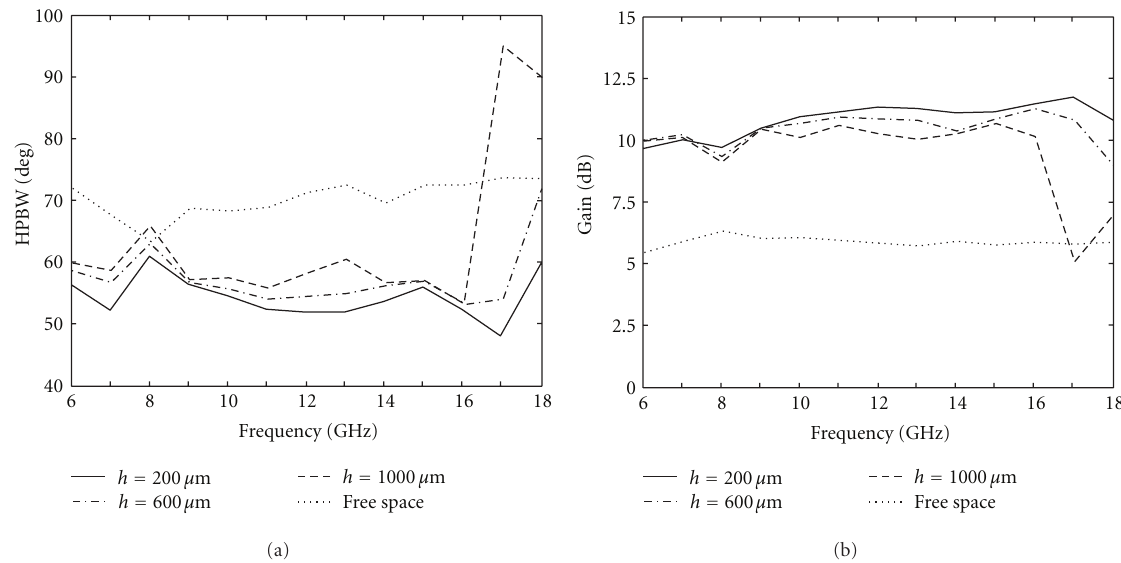
Figure 10: HPBW and maximum gain in the frequency band of the proposed slot structure for three di ff erent distances h , compared to the free space standard one.